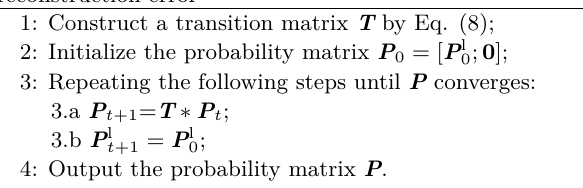
Improved label propagation based on reconstruction